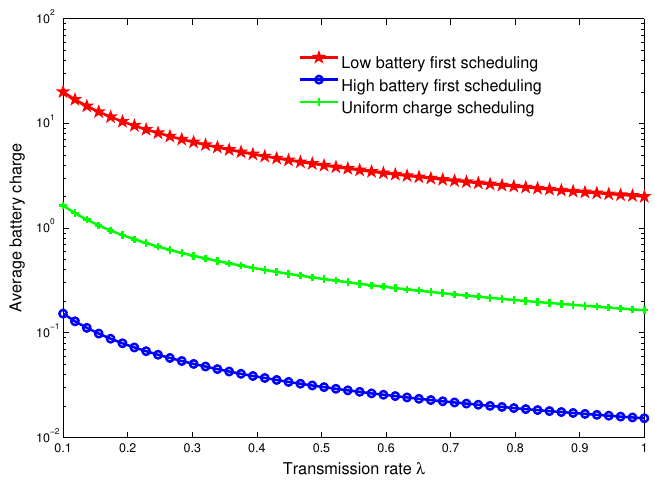
Figure 8. The average battery